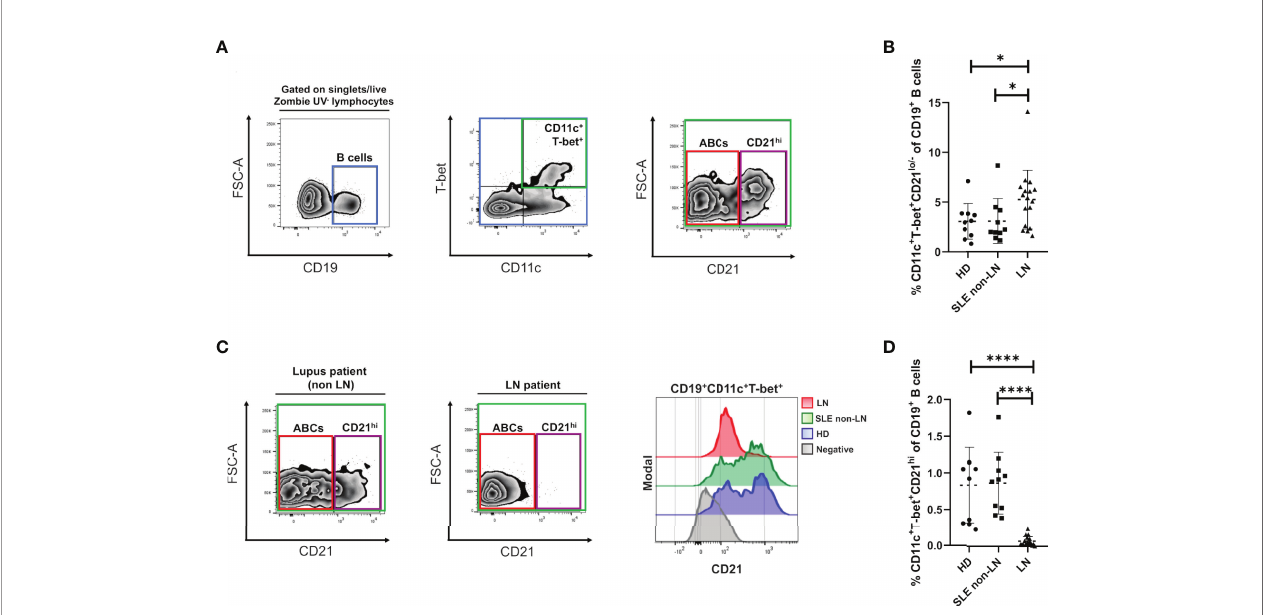
FIGURE 1 | Alterations of ABCs and CD21 hi B cell subsets in lupus nephritis. (A) Gating strategy for the identi fi cation of the indicated B cell subsets in PBMCs, selected from singlets (FSC-A vs. FSC-H), lymphocytes (SSC-A vs. FSC-A) and live Zombie UV - gates. We then selected the CD19 positive cells, to gate over the double positive cells for T-bet and CD11c. Lastly, we segregate these cells by CD21 expression into CD21 lo/- (ABCs) and CD21 hi . To depict this strategy, we present the data obtained from a representative healthy control. (B) Comparative analysis of ABCs frequencies (relative to CD19 + B cells) between cohorts of healthy donors (HD), non-LN lupus patients and LN. (C) Left: representative zebra plots from a non-LN vs. a LN patient to show lack of the CD21 hi subset. Right: representative histograms to evaluate density expression of CD21 over the CD19 + T-bet + CD11c + cells. (D) Comparative analysis of CD21 hi frequencies (relative to CD19 + B cells) between the same cohorts. All comparative analysis were assessed by a Kruskal-Wallis test followed by a Dunn ’ s post-hoc test. *p ≤ 0.05, ****p ≤